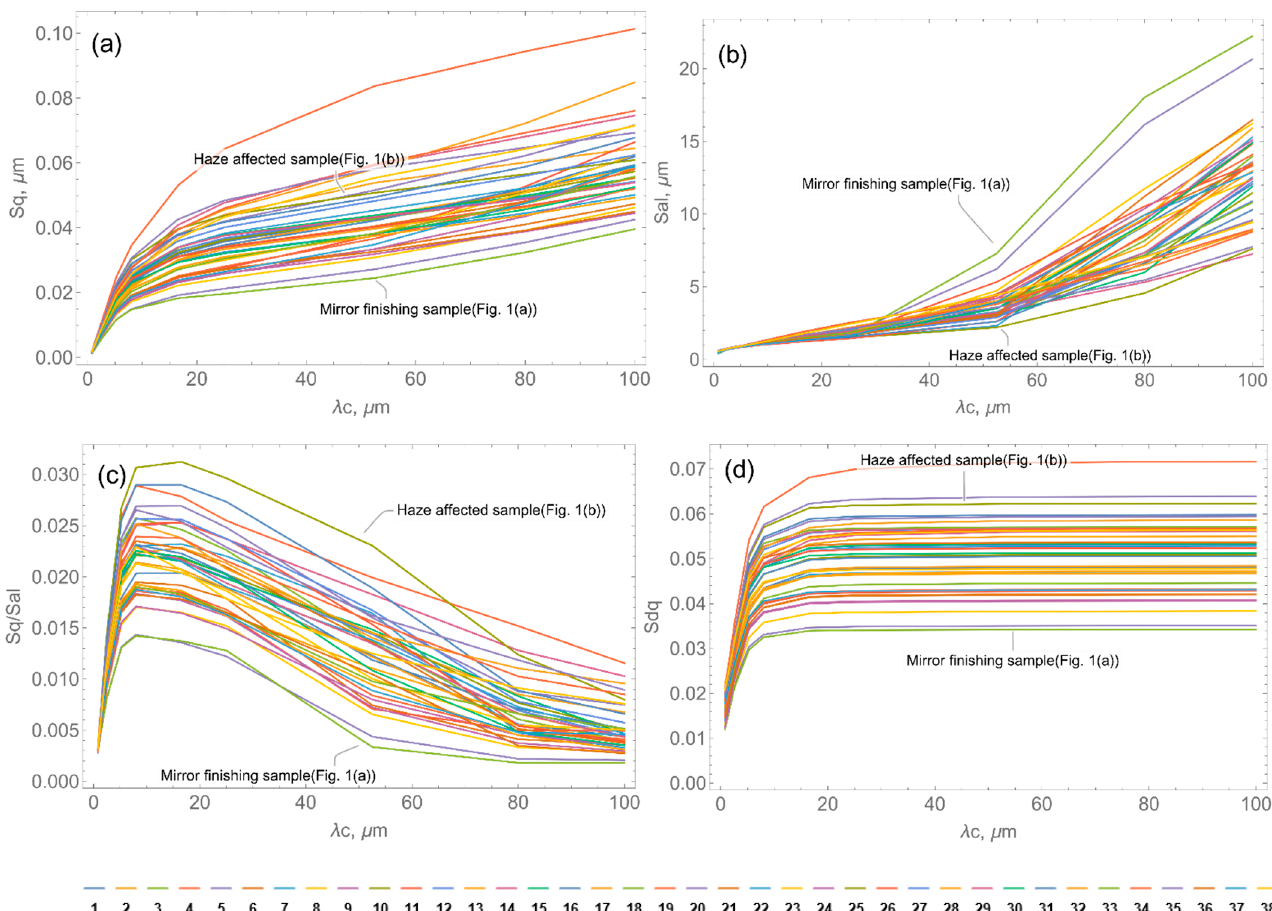
Figure 3. Values of the roughness parameters as a function of the Gaussian filter cutoff wavelengths determined from the height maps of the AISI 430 ferritic stainless steel samples: root mean square height, S q ( a ), autocorrelation length, S al ( b ), slope, S q / S al ( c ), and root mean square gradient, S dq ( d ). A legend indicating the color of lines representing the various samples is given below the graphs. The colors used for the individual samples are consistent throughout the paper. The curves for the representative samples shown in Figure 1 are marked in the figures for the sake of comparison.